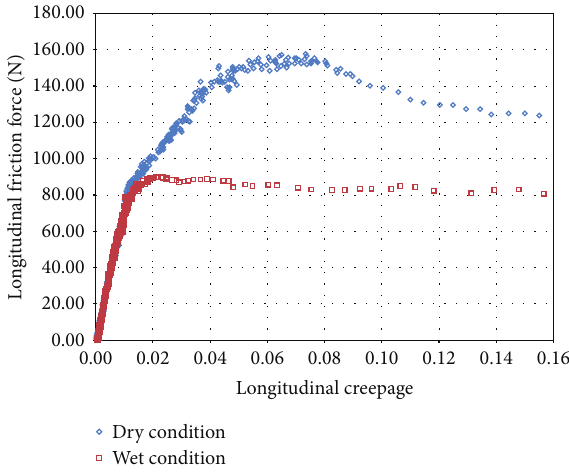
Figure 8: Creepage curve in wet and dry conditions considering a referencespeedof358 rpmandaverticalloadof47